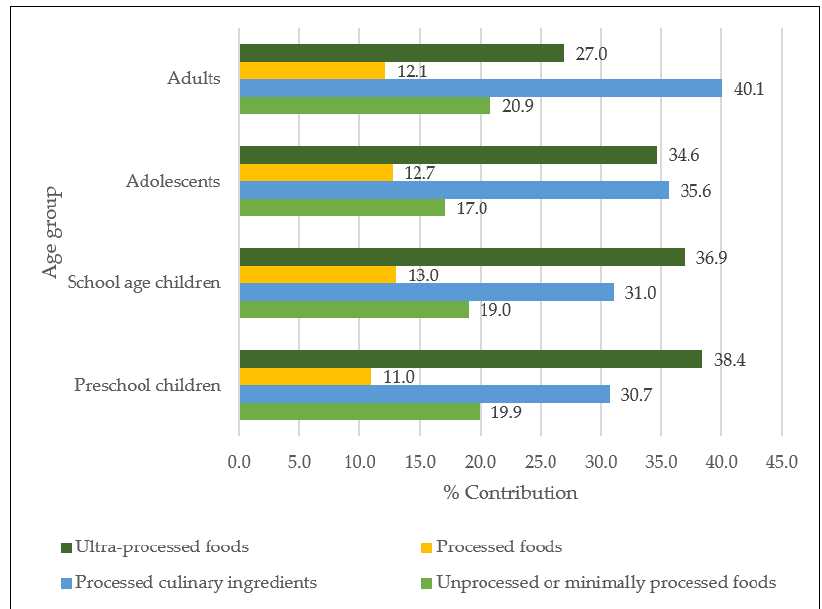
Figure 1. Percentage contribution of sodium intake by NOVA classification in the Mexican population: ENSANUT-2016.